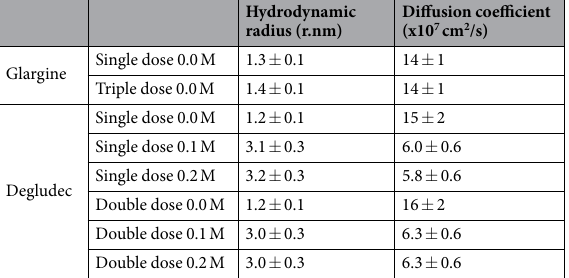
(triple dose) show matching distributions which equate to hydrodynamic radii of (1.3 ± 0.1) and (1.4 ± 0.1) nm, respectively. Insulin degludec single dose (IDS) and IDD (double dose), at unmodified ionic strengths to those of the